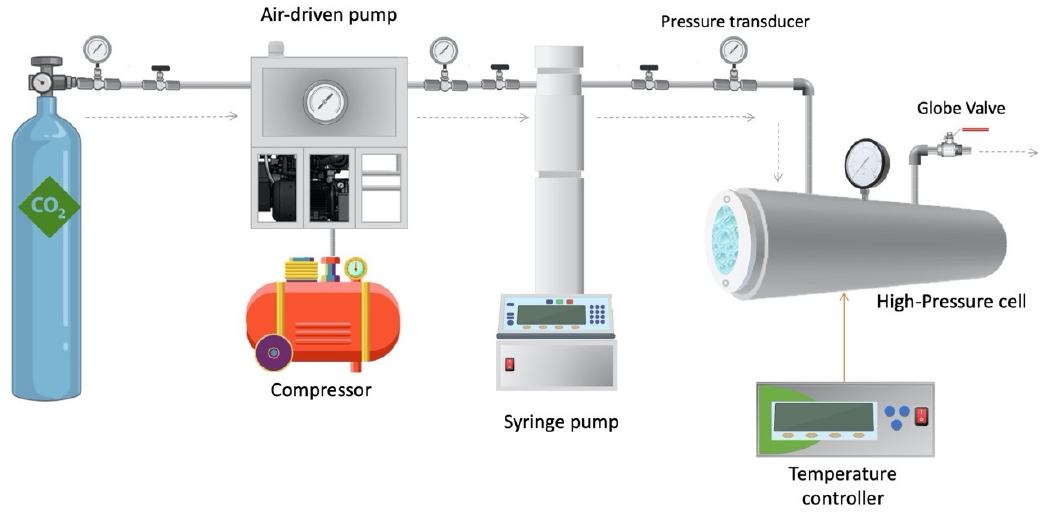
Figure 1. Outline of the experimental setup for supercritical batch foaming process.